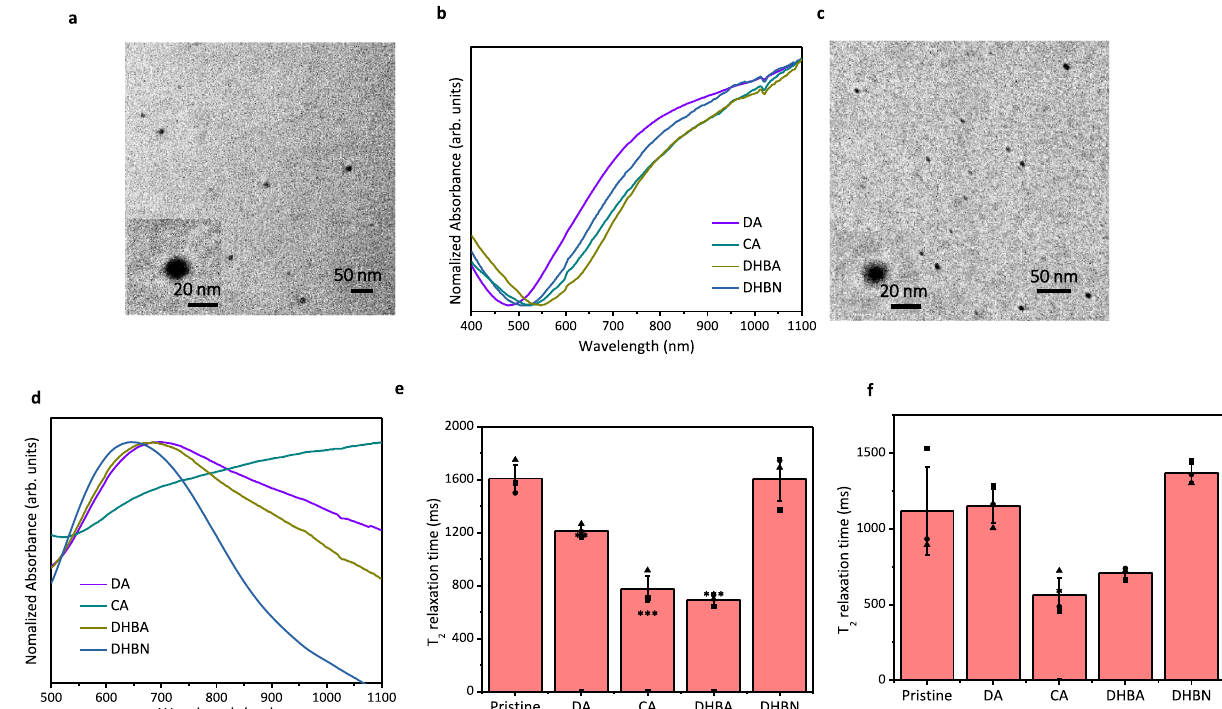
Fig. 3 General applicability of the “ partially complexed ” method. a Representative TEM images of catechol – PEDOT nanoparticles. Experiments were performed three times with similar results. b UV – Vis – NIR absorption spectra of pristine catechol – PEDOT nanoparticles. The discontinuous absorbance around 850 nm is attributed to the interchange of optical grating. c Representative TEM images of catechol – PANI nanoparticles. Experiments were performed three times with similar results. d UV – Vis – NIR absorption spectra of pristine catechol – PANI nanoparticles. The discontinuous absorbance around 850 nm is attributed to the interchange of optical grating. e , f T 2 relaxation times of PEDOT ( e ) and PANI ( f ) nanoparticles in 2 mg/mL, measured in aqueous solutions. Error bars in e , f represent mean ± s.d., with n = 3 independent experiments. Statistical signi fi cance for comparison of pristine PEDOT/PANI and catechol – PEDOT/PANI nanoparticles was determined by two-tailed Student ’ s t -test (* p < 0.05, ** p < 0.01, and *** p < 0.001). For PEDOT nanoparticles, p DA = 3.63E-03, p CA = 5.51E-04, p DHBA = 1.35E-04, p DHBN = 0.958. For PANI nanoparticles, p DA = 0.868, p CA = 0.0367, p DHBA = 0.0721,